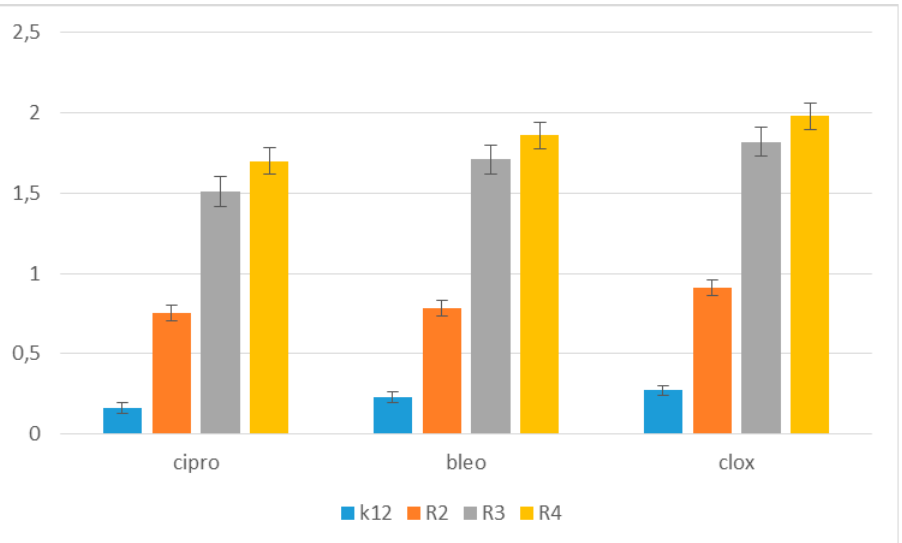
Figure 9. Examples of MIC with model bacterial strains K12, R2, R3, and R4 of the studied antibiotics with ciprofloxacin, bleomycin, and cloxacillin. The x -axis features antibiotics used sequentially. The y -axis features the MIC value in µg/mL − 1 .